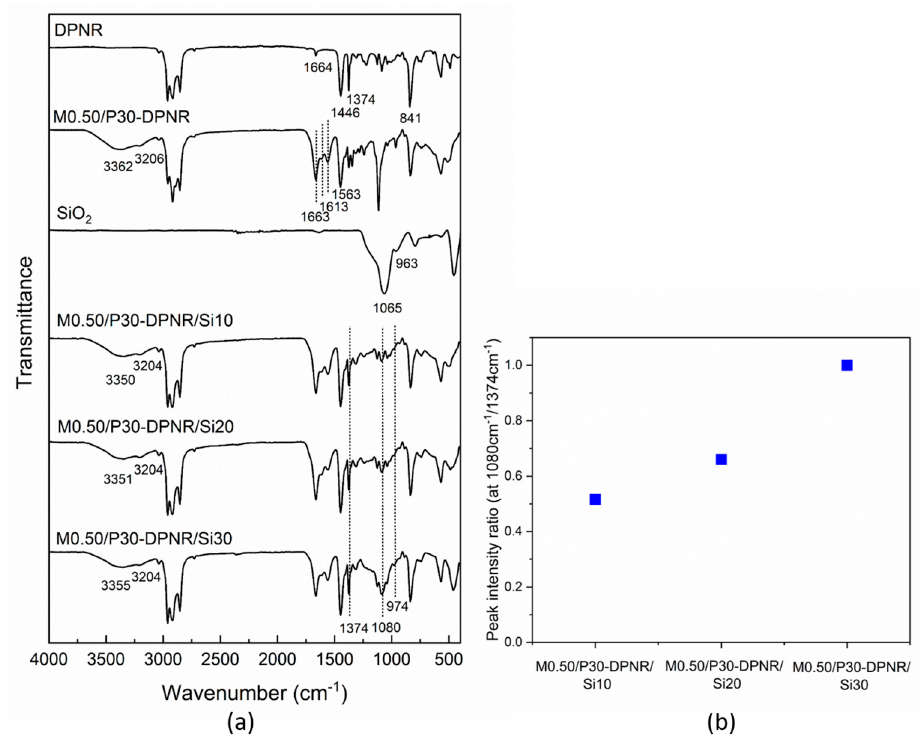
Figure 5. ( a ) FTIR of the DPNR, M0.50/P30-DPNR, silica and M0.50/P30-DPNR/silica